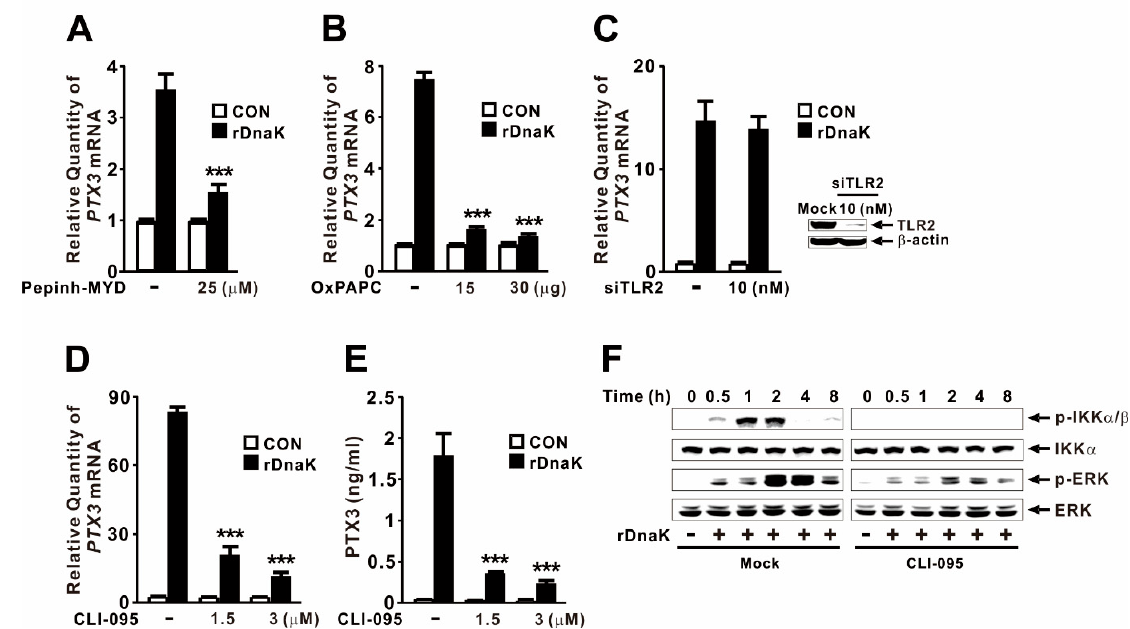
Figure 4. DnaK-induced expression of PTX3 is under the control of TLR4. The dTHP-1 cells were pretreated with either 25 μ M Pepinh-MYD for 6 h ( A ), the indicated concentrations of OxPAPC for 1 h ( B ), the indicated concentrations of CLI-095 for 6 h ( D , E ), or 1.5 μ M CLI-095 for 6 h ( F ), followed by treatment with 1 μ g/mL rDnaK for 4 h ( A , B , D ), 24 h ( E ), or the indicated times ( F ). ( C ) The dTHP-1 cells were transfected with 10 nM TLR2 siRNA (siTLR2). Forty-eight hours post-transfection, the transfected cells were treated with rDnaK (1 μ g/mL) for 4 h. After treatment, qRT-PCR, ELISA, and immunoblot analyses were performed. Data in A - E are expressed as means ± SD ( n = 3). Data in F are representative of three separate experiments. *** p < 0.001 vs. rDnaK treatment in the absence of inhibitors ( A , B , D , E ).